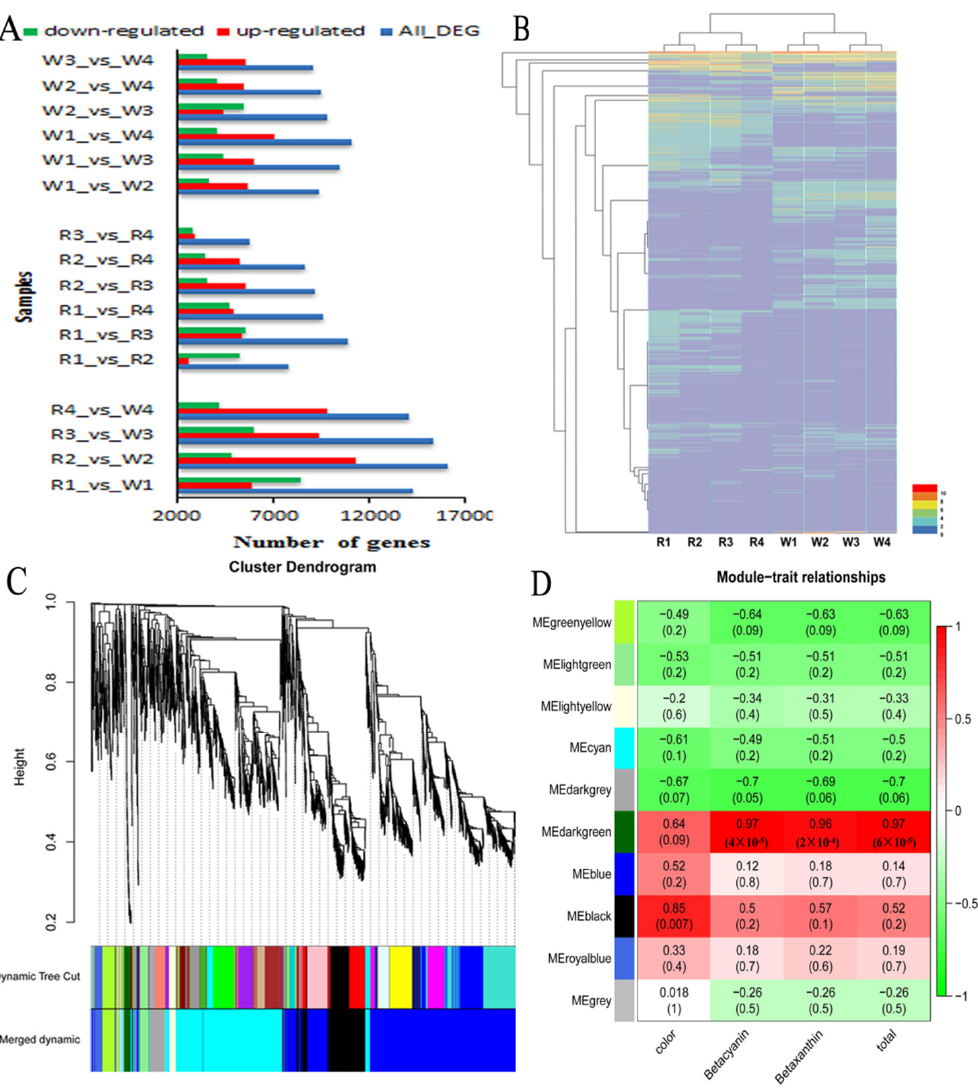
Figure 4. The identification of DEGs ( A ), Map of the number of differentially expressed genes; ( B ), Cluster map of differentially expressed genes; ( C ), Visualizing the gene network using a heatmap plot. The heatmap depicts the topological overlap matrix (TOM) among all genes in the analysis. ( D ), Module-trait associations. Each row corresponds to a module characteristic gene (eigengene), and each column corresponds to a trait.